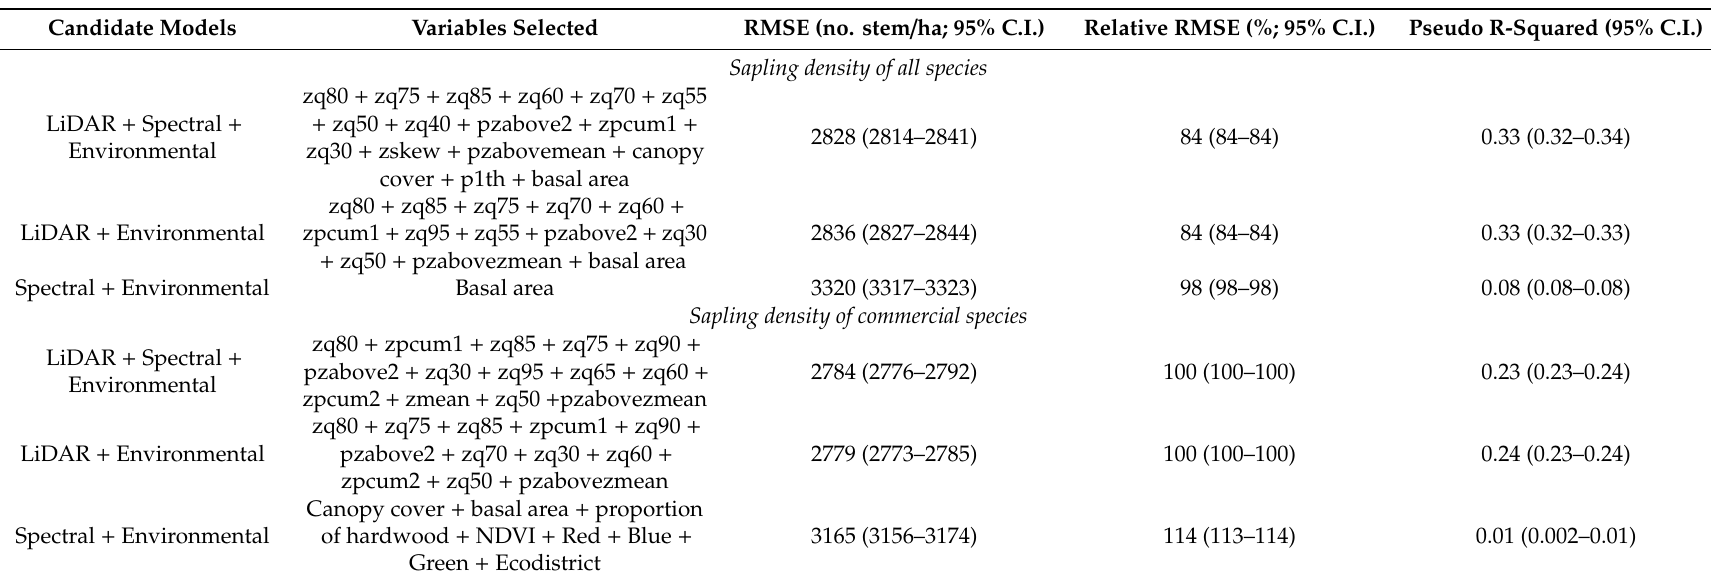
Table 3. Variables selected and comparison of root means squared error (RMSE) (stems / ha), relative RMSE (%), and pseudo R-squared of models estimating sapling density of all species and commercial species using LiDAR metrics and / or spectral variables and environmental variables. See Table 2 for meaning of variable